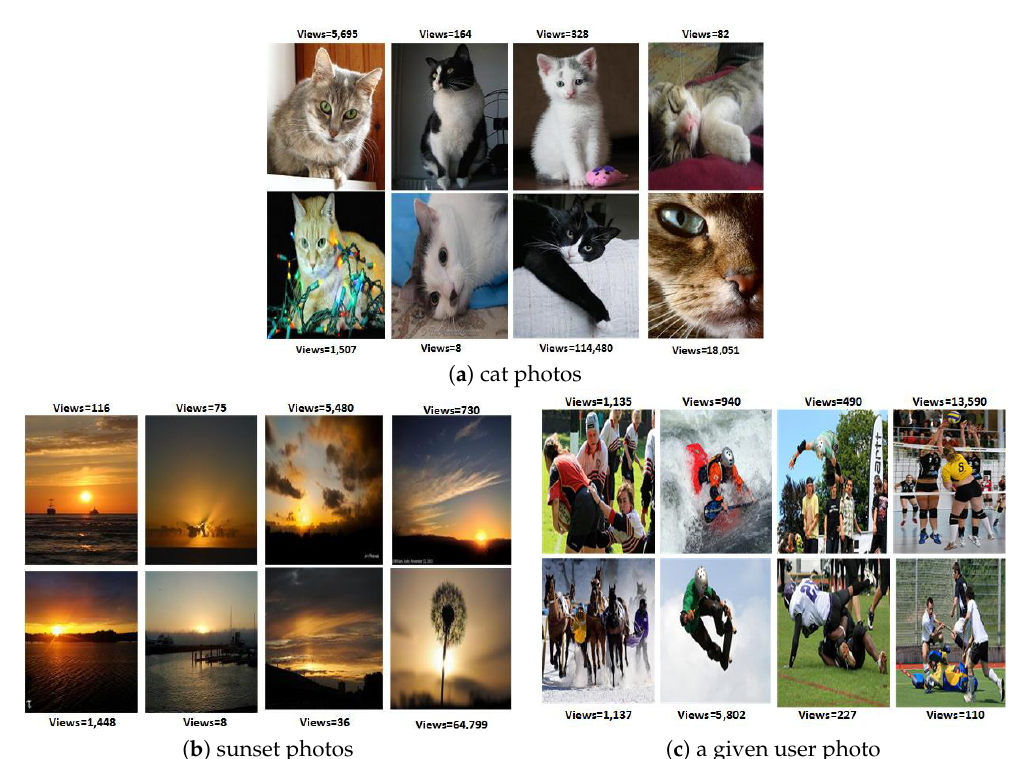
Figure 5. Variation in the popularity metric “views” for images with similar visual concepts and a user’s